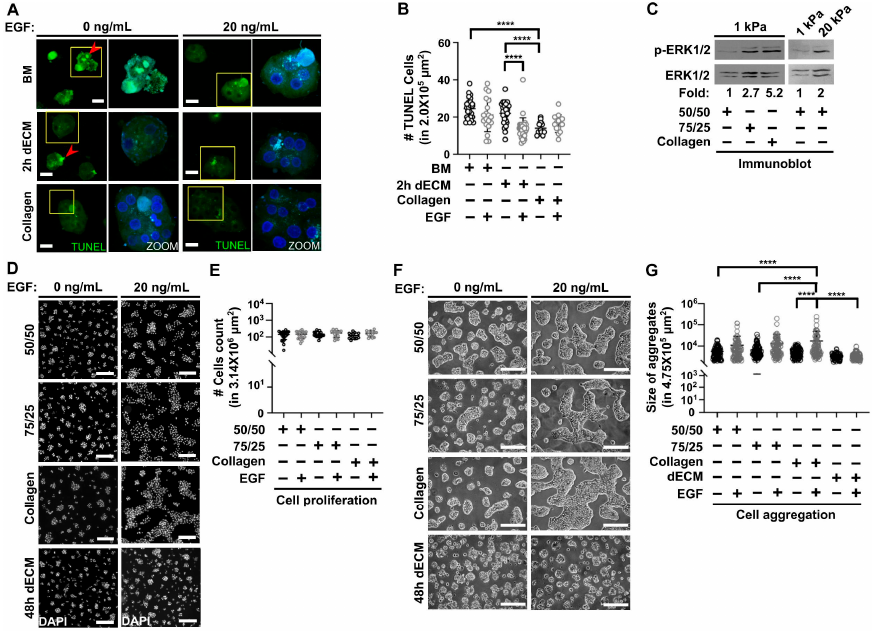
Figure 3. Collagen type I and epidermal growth factor (EGF) stimulation regulates cell viability and aggregation in primary hepatocytes cultured on soft PAA HGs. ( A ) 3D projections of representative fluorescence confocal microscopy images of hepatocytes positive to TUNEL in soft PAA HGs conjugated with collagen, BM and 2 h dECM in the absence or presence of recombinant EGF (20 ng / mL) after 72 h of culture. Apoptotic hepatocytes with double-strand DNA breaks: red arrowheads. Images were obtained from a 40 × objective. Scale bar: 20 µ m. ( B ) Quantification of positive TUNEL cells in soft PAA HGs conjugated with collagen I, BM, or 2 h dMEC in the absence or presence of EGF [20 ng / mL]. Data are represented as the mean ± SD of 2 independent experiments; **** p < 0.0001. ( C ) phospho- extracellular signal-regulated kinases 1 / 2 (ERK1 / 2) and ERK1 / 2 immunobotting in hepatocytes cultured on 1 kPa and 20 kPa PAA HGs conjugated with di ff erent ECM after 24 h of culture. Data presented are representative of 2 independent experiments. Numbers below blots indicate the densitometric ratio values of phospho-ERK1 / 2 and total ERK1 / 2 protein, expressed in fold changes. ( D ) Representative fluorescence images of nuclei (DAPI) in hepatocytes after 72 h of culture on soft PAA HGs conjugated with di ff erent ECMs in the absence or presence of EGF (20 ng / mL). Images obtained using a 10X objective. Scale bar: 200 µ m. ( E ) Cells count graph of conditions depicted in ( D ). ( F ) Representative DIC images of aggregates of primary hepatocytes cultured on 1 kPa PAA-HGs linked to di ff erent ECMs in the absence or presence of EGF (20 ng / mL) at 72 h of culture. Images were obtained from a 20x objective. Scale bar: 200 µ m. ( G ) Quantification of size of cell aggregates in the conditions depicted in ( F ). ECM mixtures: BM, 100% Matrigel; 50 / 50, 50% collagen type I puls 50% BM; 75 / 25, 75% collagen type I plus 25% BM; collagen, 100% collagen type I; 2 h dECM, dECM after 2 h of digestion; 48 h dECM: ECM after 48 h of digestion. Data are represented as mean ± SD of 2 independent experiments; **** p <